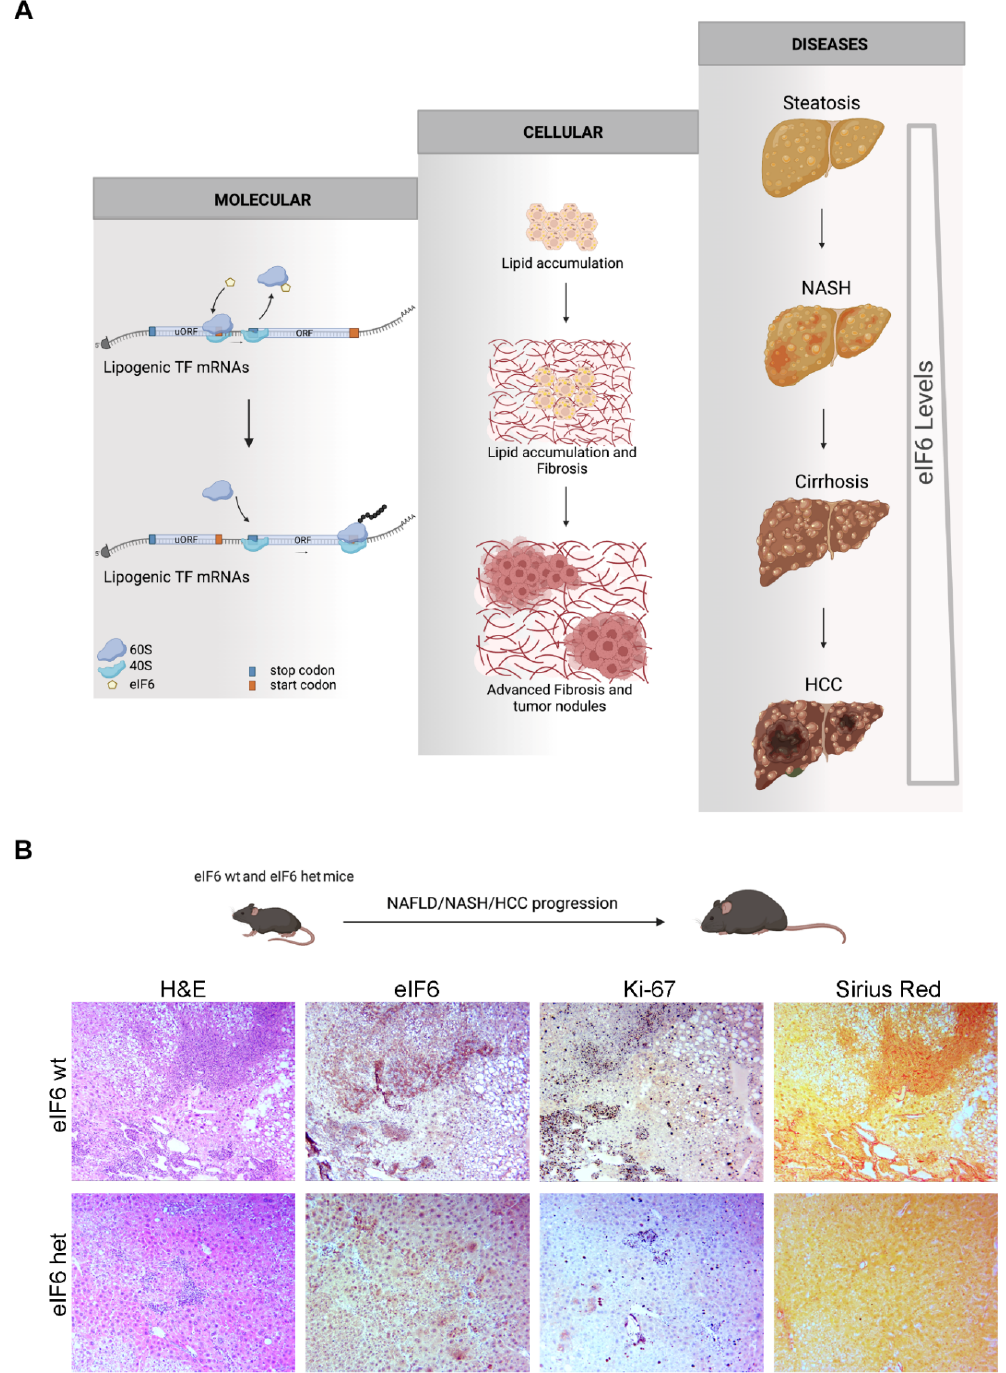
Figure 2. eIF6 levels mark the progression from NAFLD to HCC. ( A ) Increased levels of eIF6 mark this progression, acting as an amplification loop at the molecular and cellular levels of lipid synthesis. Increased eIF6 expression leads to the augmented translation of lipogenic factors [12] containing uORFs (upstream open reading frames) in their 5 (cid:48) UTR. The molecular mechanism leads to more lipid accumulation, premature fibrosis, and tumor nodules. At the expression level, the eIF6 protein augments throughout the process worsening the outcome of HCC [91]. ( B ) During NAFLD/NASH progression to HCC, heterozygous mice for eIF6 have reduced fibrosis, as shown by Sirius Red staining, and less proliferation, as shown by Ki-67 staining